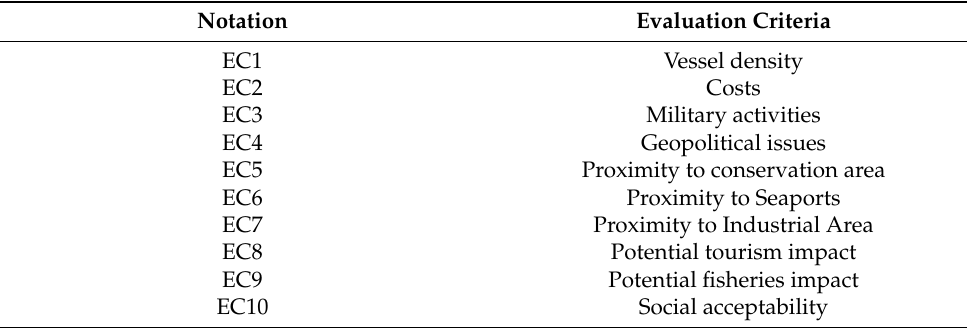
Table 5. List of evaluation